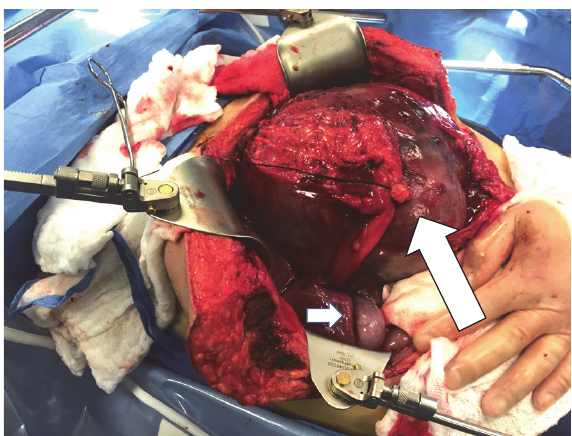
Figure 3: Tumor occupying entire epigastrium. Large arrow shows the round ligament secured by a suture. Short arrow points to gallbladder.